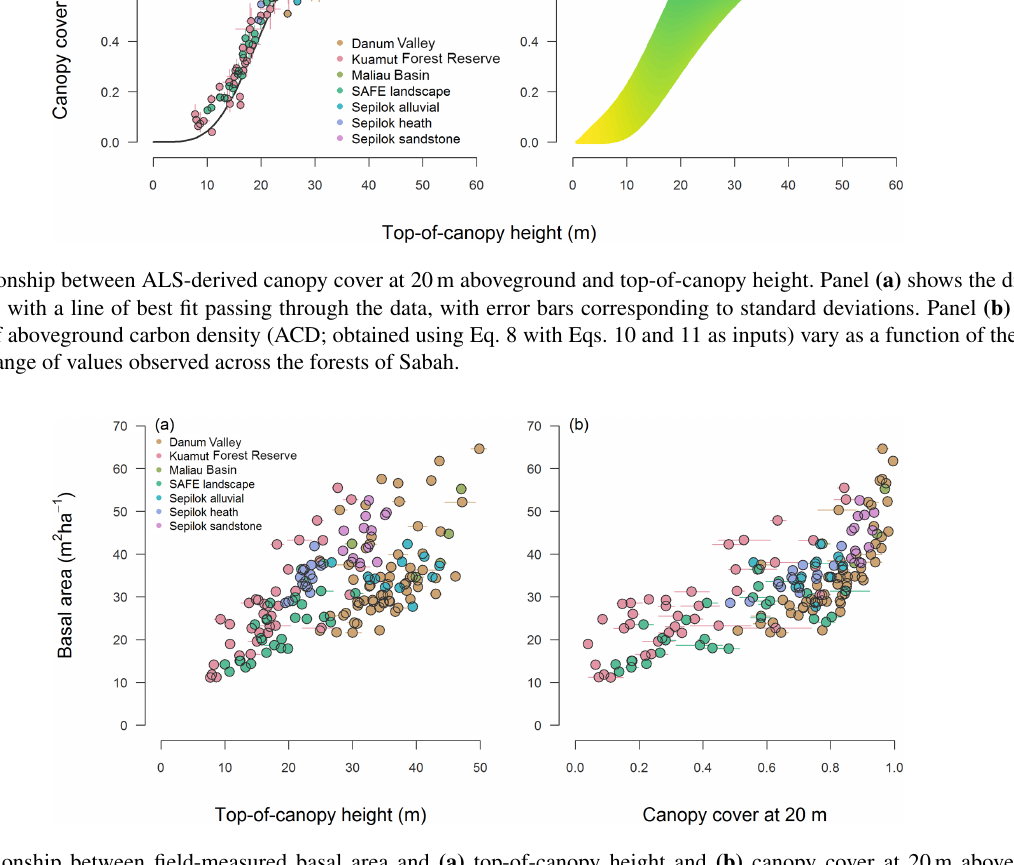
Figure 4. Relationship between field-measured basal area and (a) top-of-canopy height and (b) canopy cover at 20m aboveground as measured through airborne laser scanning. Error bars correspond to standard